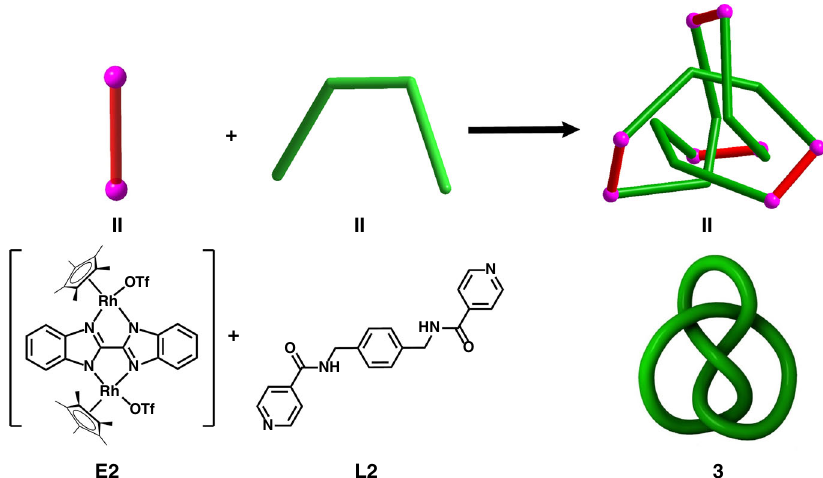
Fig. 6 Synthesis of octanuclear fi gure-eight knot 3 . Schematic representation of the synthesis of 3; The stick model (top) and schematic representation (below) of E2 and L2 ; The stick model (top) and simpli fi ed image of